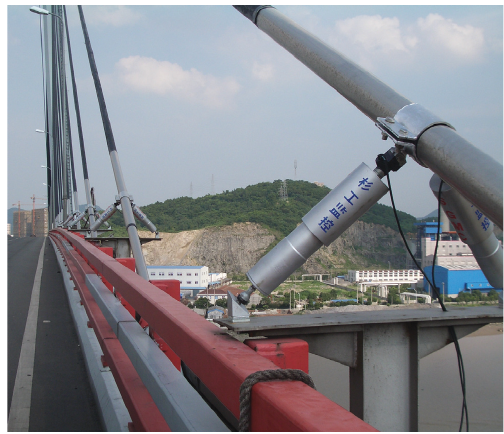
Figure 1: SG-MRD60 and its application.